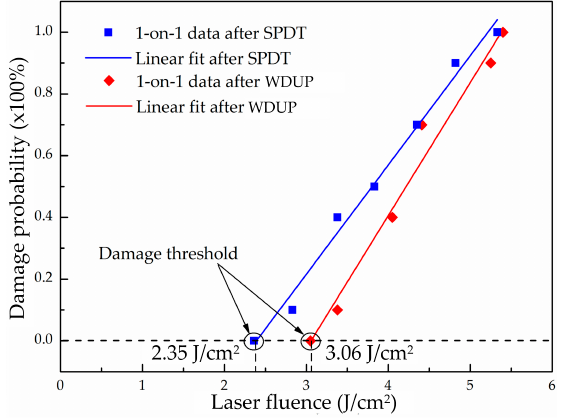
Figure 6. Laser induced damage threshold (LIDT) calculation of the tested KDP crystals. Table 2. LIDT test results of KDP samples with different processing methods (6 crystals in each group, test environment: temperature 25 °C, humidity 43% RH).